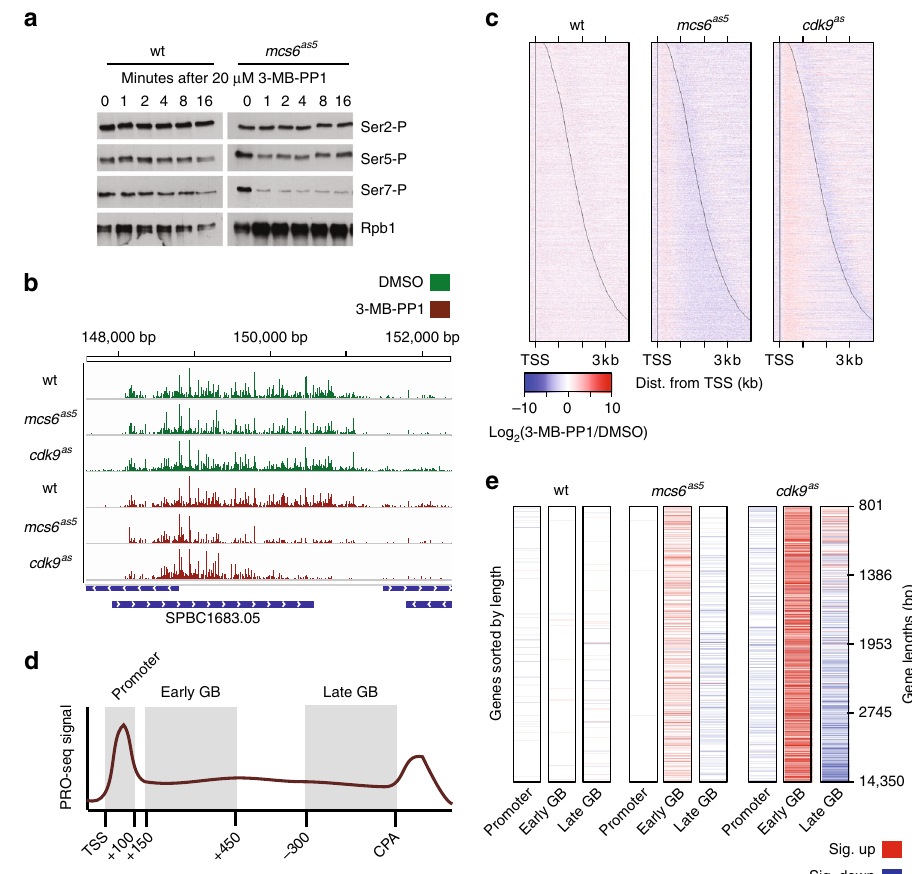
Fig. 2 Mcs6 and Cdk9 impact Pol II at 5 ′ and 3 ′ ends of genes. a Western blot analysis of phosphorylated CTD residues (Ser2-P, Ser-5-P, Ser7-P) in relation to total CTD signal. Levels were measured over a time course of cultures treated with 20 μ M 3-MB-PP1. b Browser track image from the SPBC1683.05 locus displaying normalized read counts from untreated (green) and treated data (red) for wild-type, mcs6 as5 , and cdk9 as strains from top to bottom, respectively (plus strand only). All PRO-seq samples represent treatments for 5 min with 10 μ M 3-MB-PP1 (treated) or equivalent volume of DMSO (untreated). c Heat maps depicting the log 2 fold change in normalized PRO-seq signal (treated/untreated) within 10 bp bins from − 250 bp to +4000 bp relative to the TSS ( “ + ” indicates downstream and “ − ” indicates upstream) for wild-type, mcs6 as5 , and cdk9 as strains from left to right, respectively. Data used in b and c re fl ect the results of combined data from two biological replicates for each treatment. Only one replicate was used for 3-MB-PP1-treated mcs6 as5 (see Methods). Genes within each heat map are sorted by increasing length from top to bottom, with black lines representing observed TSS and CPS ( n = 3383). d Hypothetical plot for the illustration of the de fi nition of promoter (TSS to +100) early (+150 to +450 from TSS) and late ( − 300 to 0 from CPS) gene body regions used in e . e Heat maps depicting whether each gene exhibits a signi fi cant fold change (adjusted p < 0.01; treated/untreated; DESeq2: Wald test, Benjamini and Hochberg ’ s correction) in promoter, early, or late gene body regions. Genes were required to be longer than 800 nt ( n = 3003) and are sorted from top to bottom by increasing gene length with length quartiles shown on the right. Signi fi cant increases and decreases in each region are shown as red and blue,